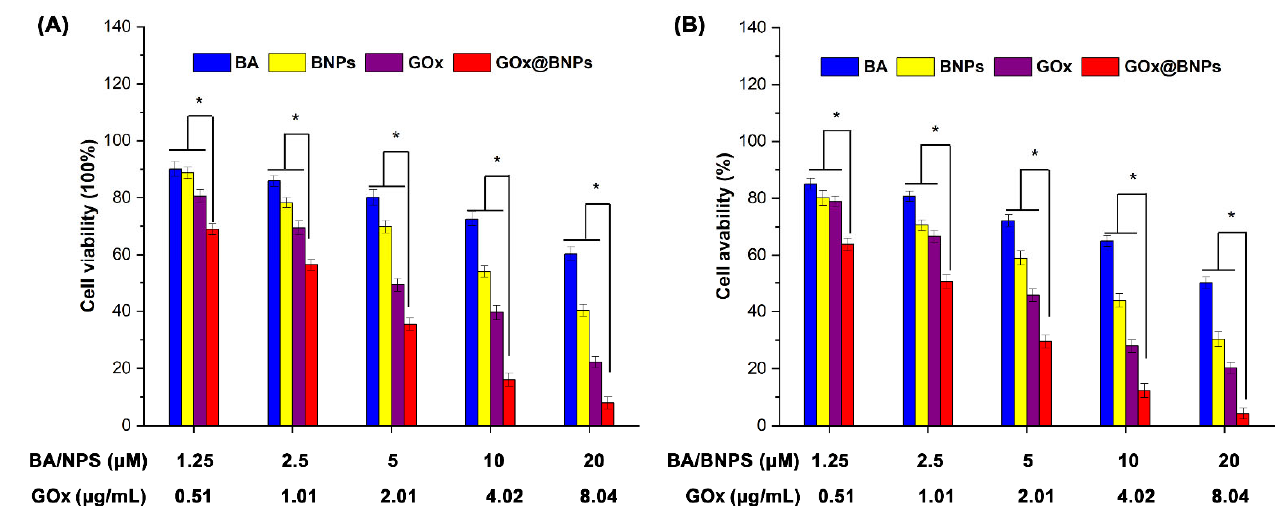
Figure 4. In vitro cytotoxicity of different groups against ( A ) MCF ‐ 7 and ( B ) A549 cancer cells at 37 °C for 24 h by intracellular drug delivery (* p < 0.05).